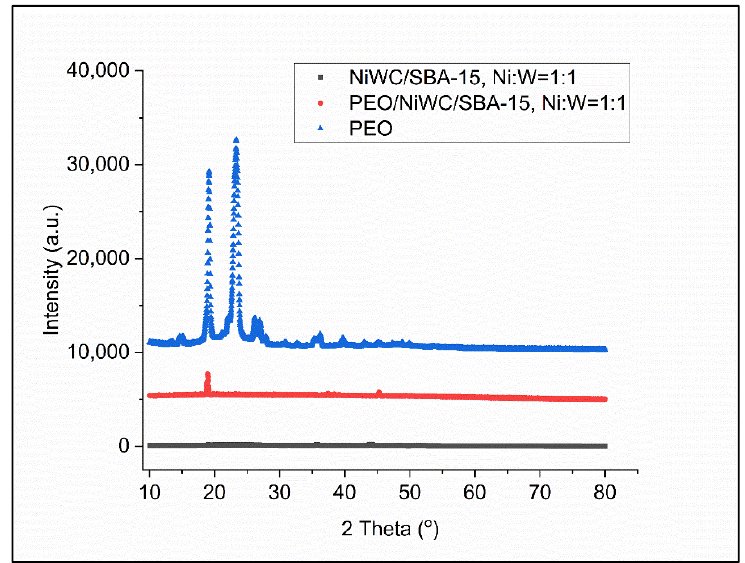
Figure 1. XRD patterns of the PEO, NiWC/SBA-15 (Ni/W = 1:1), and PEO/NiWC/SBA-15 (Ni/W = 1:1).